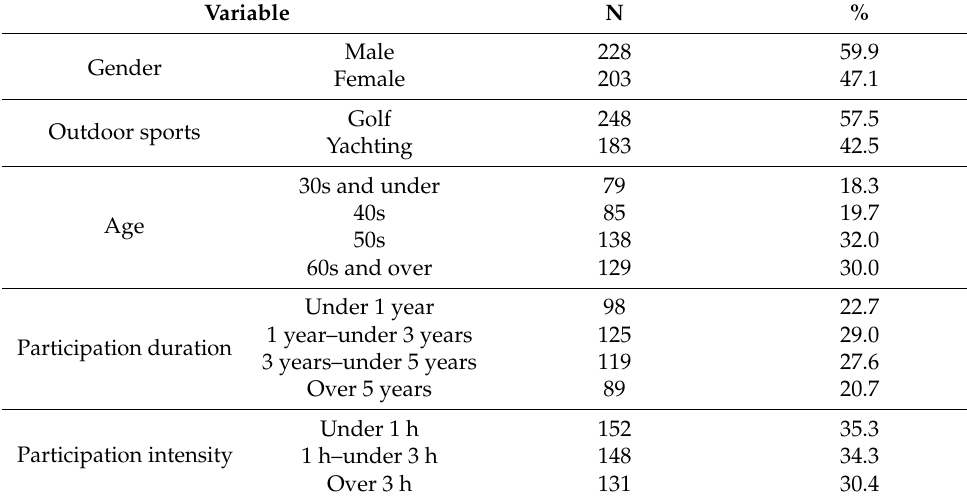
Table 1. Characteristics of outdoor sports